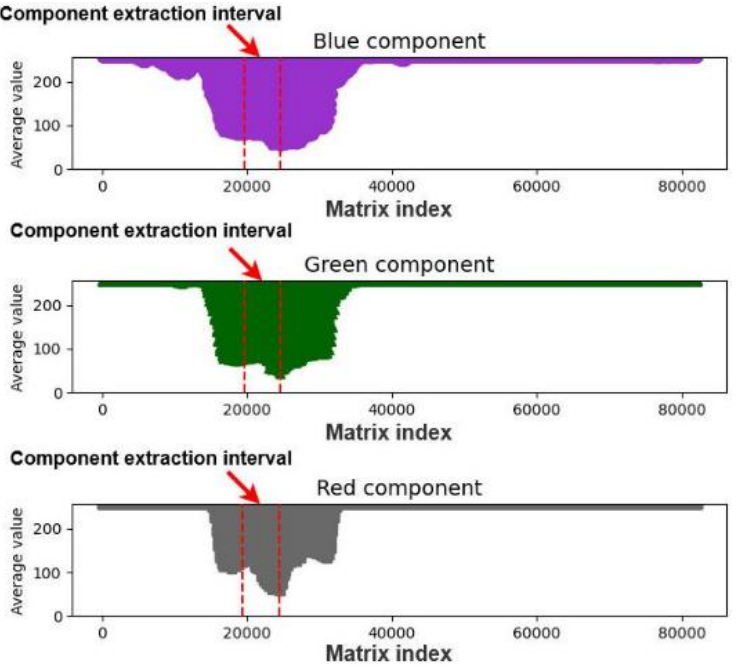
Figure 13. Plot of the color component extraction interval.